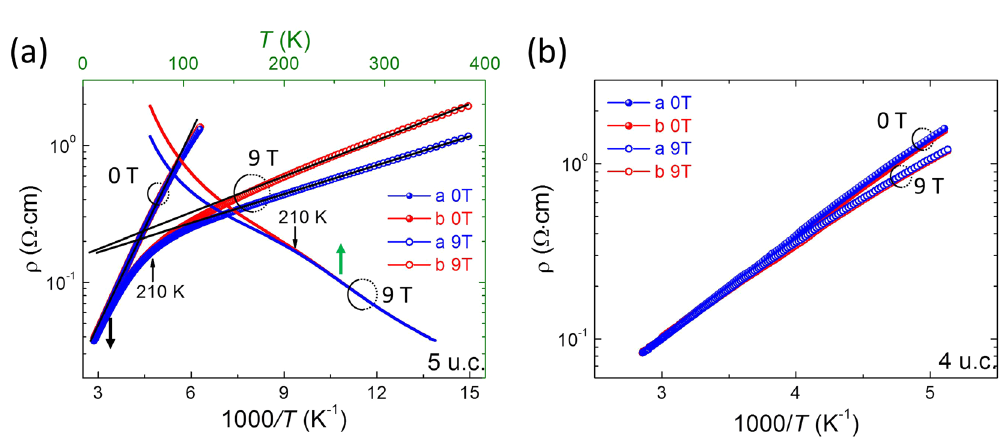
Figure 3. Log plot of resistivity along a and b -axes as a function of 1000/ T and/or T for ( a ) 5 uc LSMO films and ( b ) 4 uc LSMO film with and without 9T magnetic field. The magnetic field was along out of plane